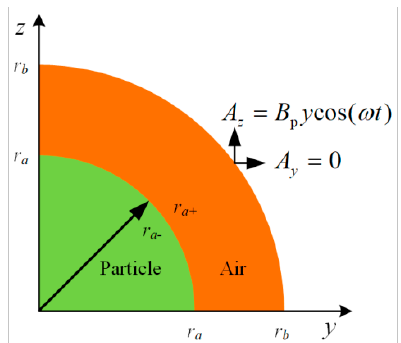
Figure 2. 2D model of a 1/4 wear particle in the alternating magnetic field.